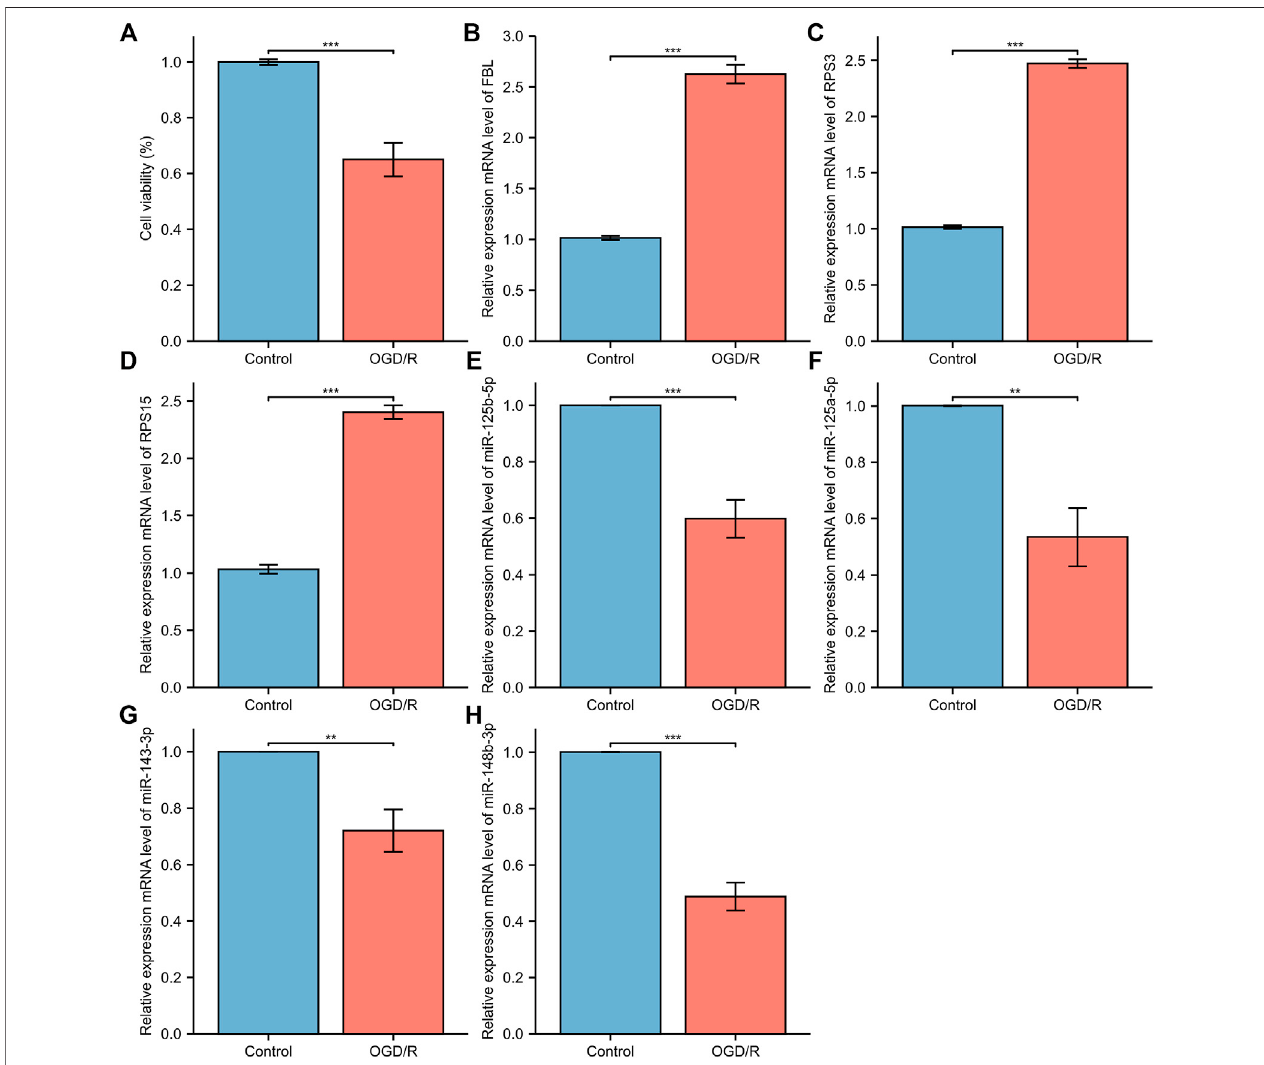
FIGURE 15 | The relative expression of differentially expressed mRNA and miRNA in HT22. (A) The CCK-8 cell viability assay; (B) FBL (C) RPS3; (D) RPS15 (E) miRNA-143-3p (F) miRNA-148b-3p; (G) miRNA-125b-5p; (H) miRNA-125a-5p. The control group re fl ects the normal HT22 and the OGE/R group re fl ects the model group. * p < 0.05, ** p < 0.01, *** p <